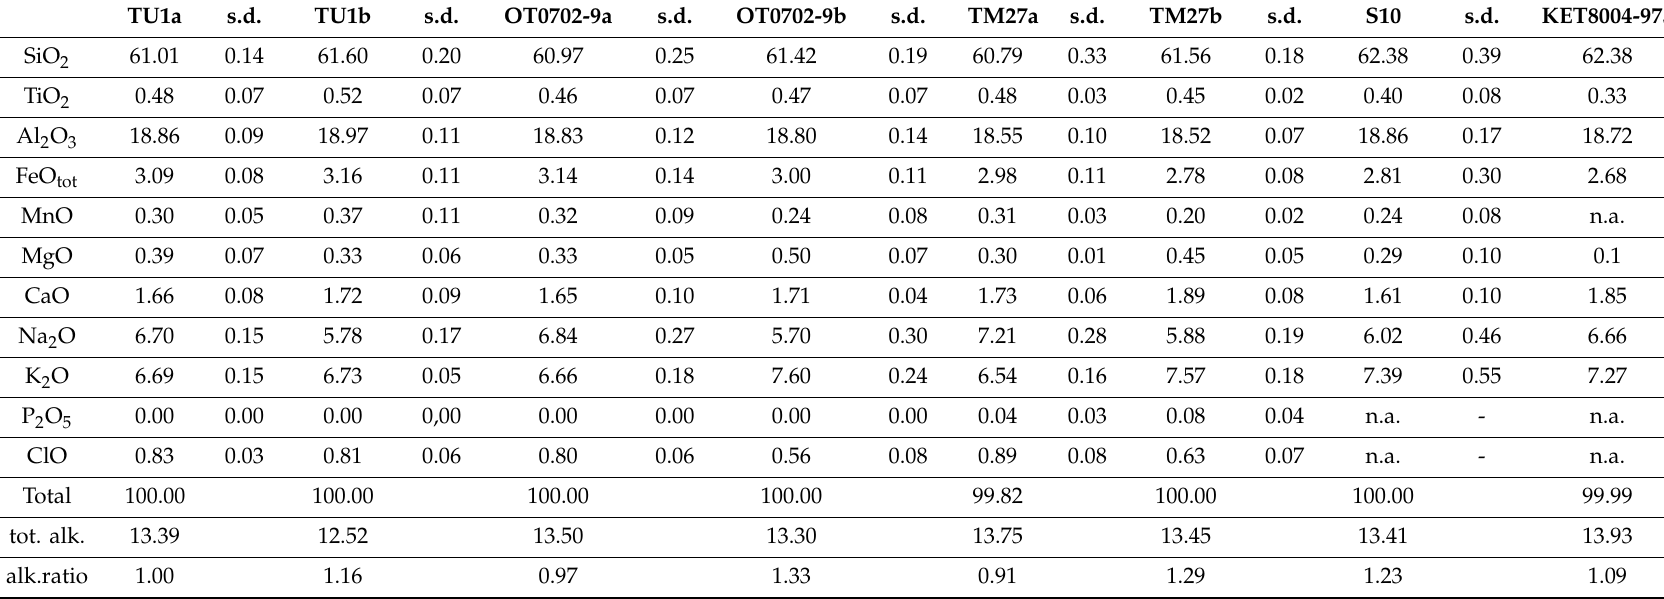
Table 3. Comparison among the EDS data related to the ash sample TU1 and the X-6 tephra composition of the Central Mediterranean. The references of X-6 tephra are as follows: OT0702-9 by Vogel et al. (2010) [79], TM27 by Wulf et al. (2008) [78], S10 by Munno et al. (2007) [77], KET8004-975 by Paterne et al. (1988) [76]. s.d.: Standard deviation, n.a.: not